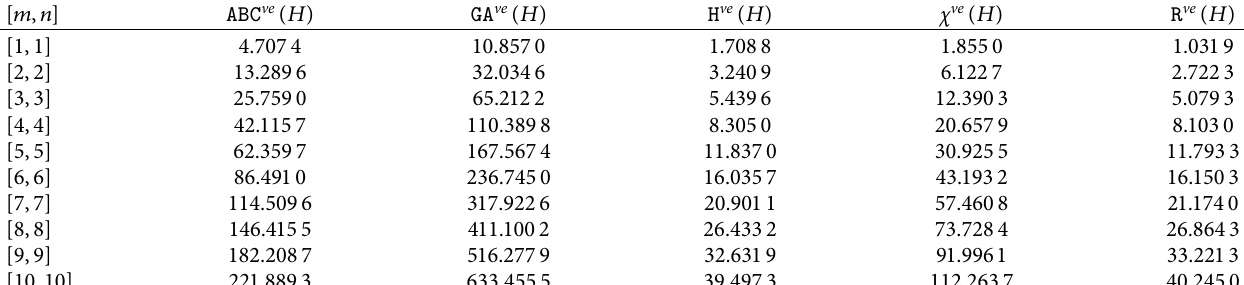
Table 5: Numerical results of indices for vanadium carbide.